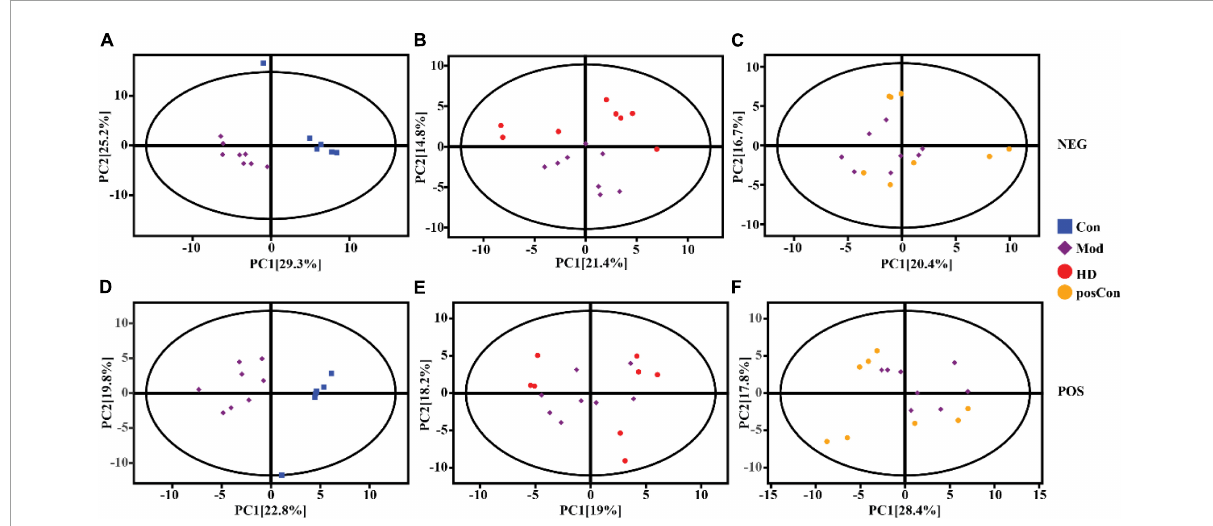
FIGURE2 PCA score scatter plots showing clustering of plasma metabolites detected in ESI- mode (NEG) and ESI + mode (POS). (A) Mod vs. Con (NEG, R 2 X = 0.62), (B) HD vs. Mod (NEG, R 2 X = 0.58), (C) posCon vs. Mod (NEG, R 2 X = 0.51), (D) Mod vs. Con (POS, R 2 X = 0.55), (E) HD vs. Mod (POS, R 2 X = 0.59), (F) posCon vs. Mod (POS, R 2 X = 0.55).